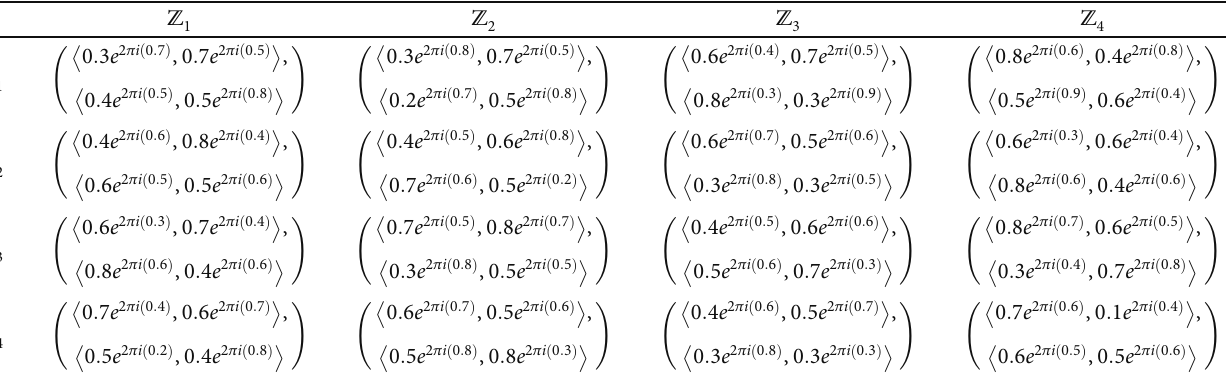
Table 3: Cq-ROFR evaluation information given by expert E 3